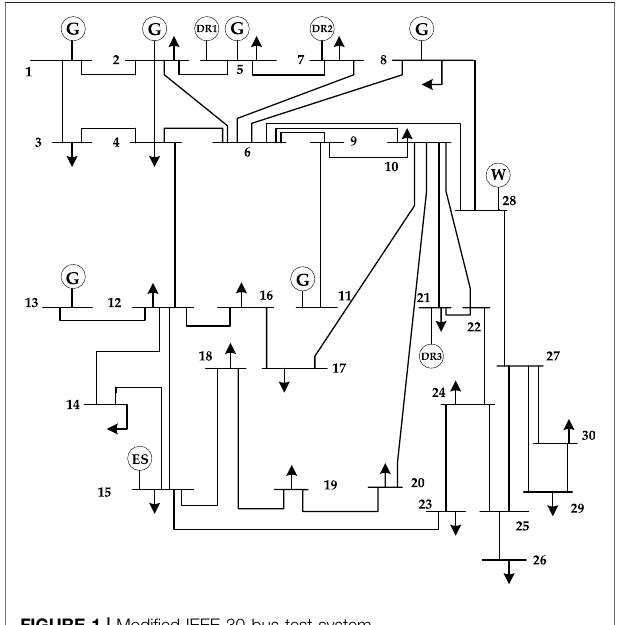
FIGURE 1 | Modi fi ed IEEE 30-bus test system.